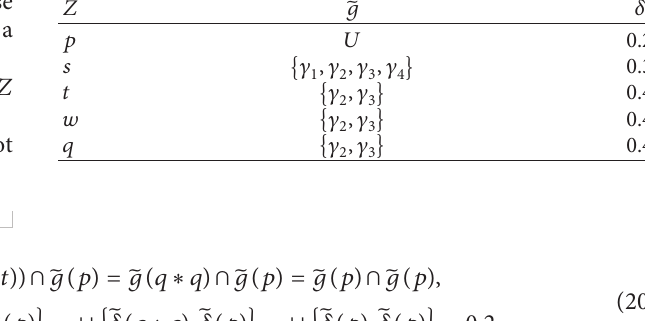
Table 8: Table representation of hybrid structure 􏽥 g